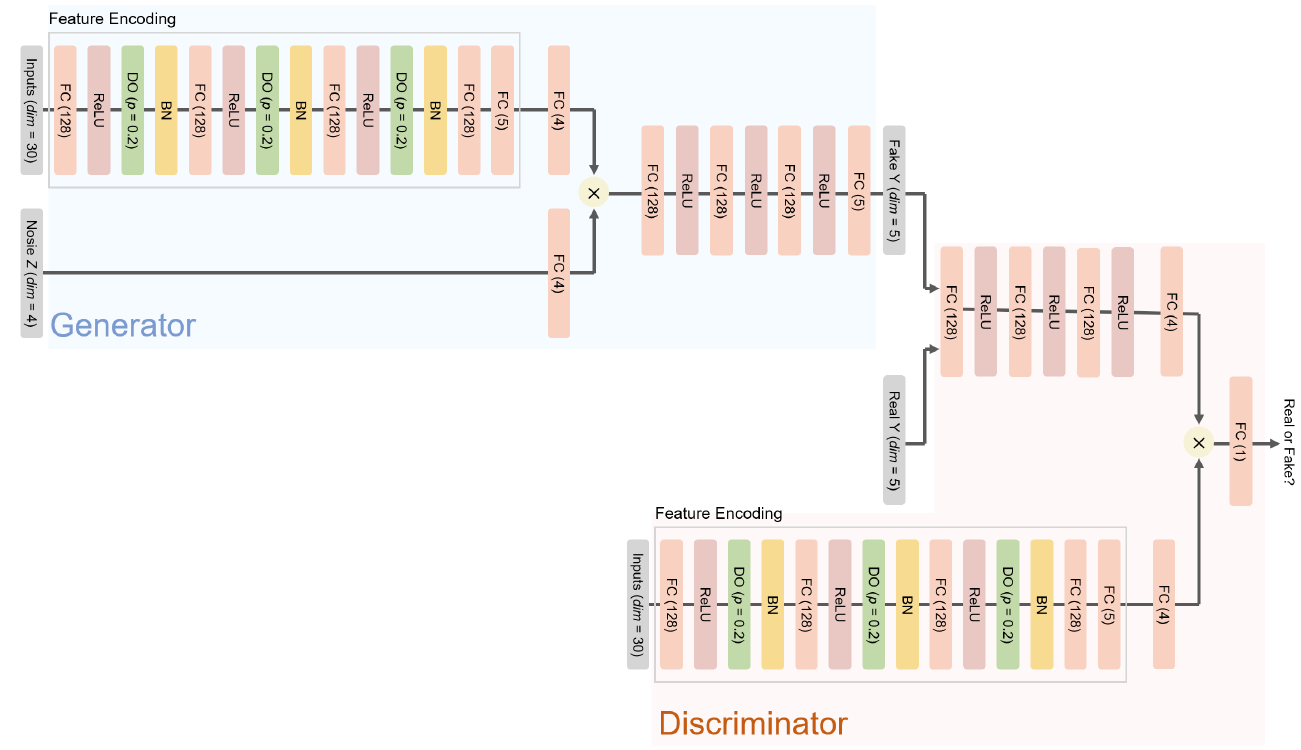
Figure 2. Neural network architectures of the proposed model (cGAN-UC-3). FC ( n ) indicates a fully connected layer with n nodes. DO ( p = r ) indicates a dropout layer with a dropout probability of r . BN represents the batch normalization. For other models, i.e., cGAN-UC- k , the numbers of fully connected layers, i.e., FC (128), in the generator and discriminator change to k